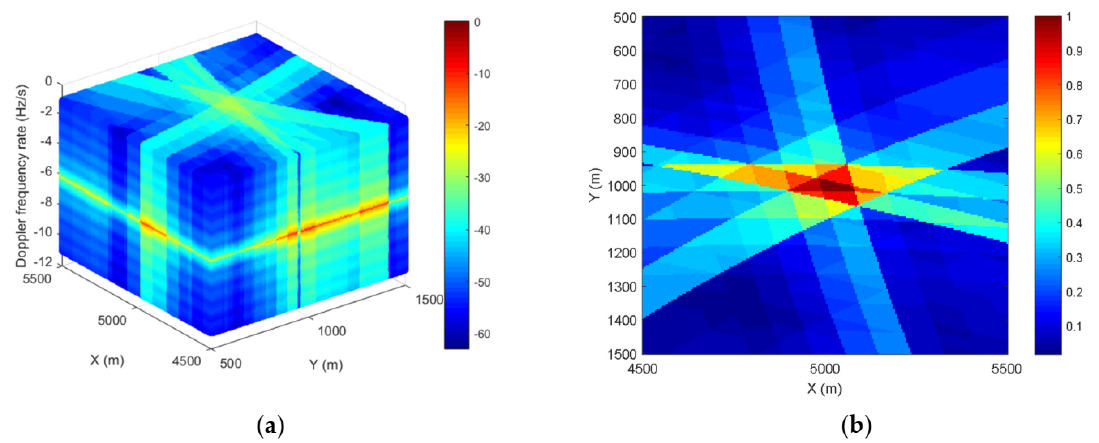
Figure 9. The multi-source fusion results of the target echo. ( a ) The target fusion result in Cartesian- DFR domain; ( b ) The slice of the fusion result along DFR bins.